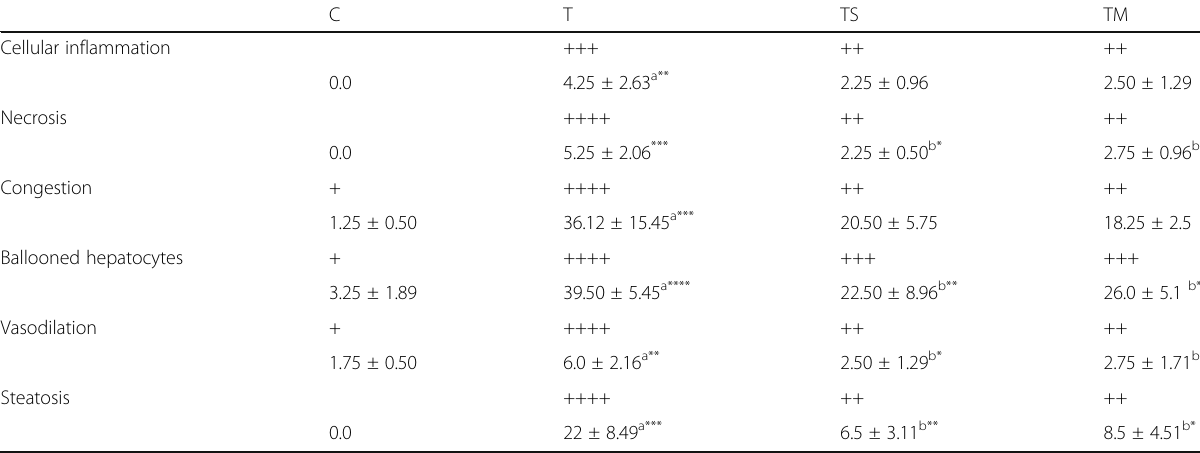
Table 5 In situ evaluation of the effect of SCG and MCG on liver treated with SCG and MCG post CCl 4 -induced hepatotoxicity C T TS TM Cellular inflammation +++ ++ ++ 0.0